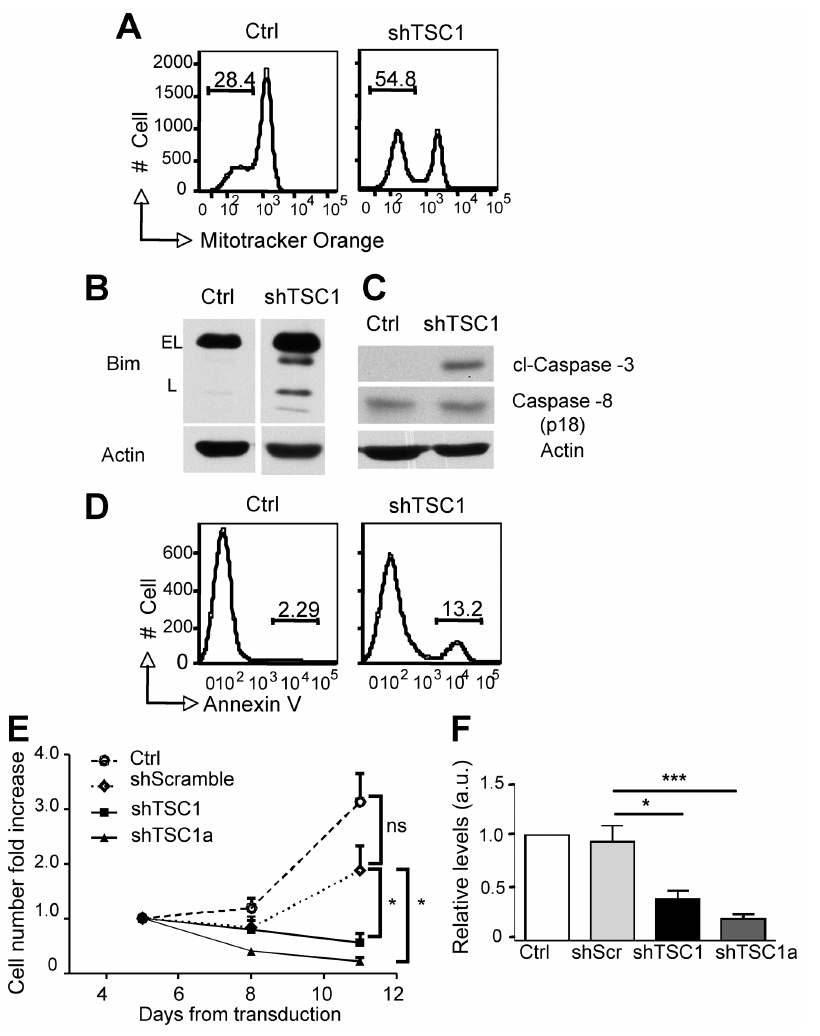
Figure 5. shRNA-assisted TSC1 knock down hinders survival of primary human T cells. shTSC1 cells were obtained by lentiviral-mediated infection and Puromycin selection as indicated in Figure 4A. Control cells and TSC1 knock down cells were harvested at day 8 (three days after Ficoll) and stained with the Mitotracker Orange dye, or with Annexin V and analyzed by FACS (A and D, respectively), or lysed and analyzed by WB (B–C). In A and D, histograms are representative of 4 independent determinations. E) Cell viability of control cells and cells infected with shScrambled, shTSC1 and shTSC1a-recombinant lentiviral vectors was determined over time by Trypan blue counts. Data are depicted as fold changes over the input, and are representative of mean 6 SEM of four independently performed experiments. Statistical significance at day 11 was evaluated by unpaired two- tailed Student t-Test. F) TSC1 levels 6 SEM of Ctr, shScrambled, shTSC1 and shTSC1a-infected cells were analyzed by WB analysis in four independent determinations. Statistical significance was evaluated by unpaired two-tailed Student